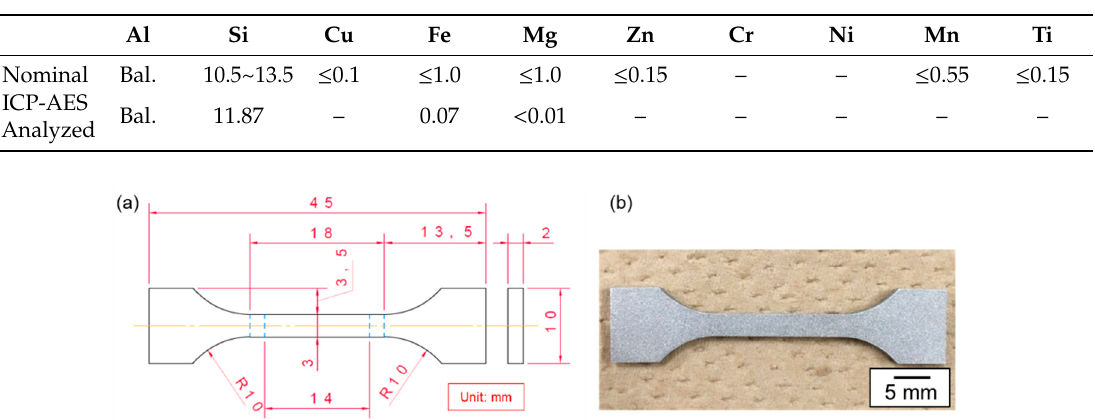
Table 1. The chemical composition of the LPBF-fabricated Al–12%Si alloy sample (mass%) analyzed by using inductively coupled plasma atomic emission spectrometry (ICP-AES).